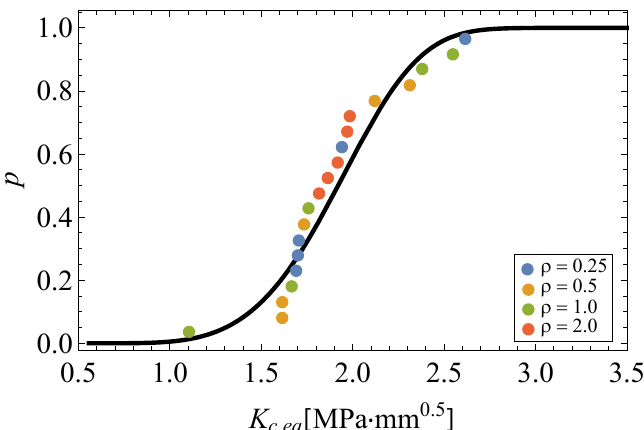
Figure 7. Equivalent fracture toughness and Weibull distribution based on the Bernard plotting position. − Step 4: Derivation of the probabilistic K N − ρ 0.5 field . Finally, the probabilistic defi- c nition of the equivalent fracture toughness can now be extended to any other notch radii condition based on the TCD method by substituting the equivalent fracture toughness K N from Equation (14) in Equation (13), resulting in the percentile curves c